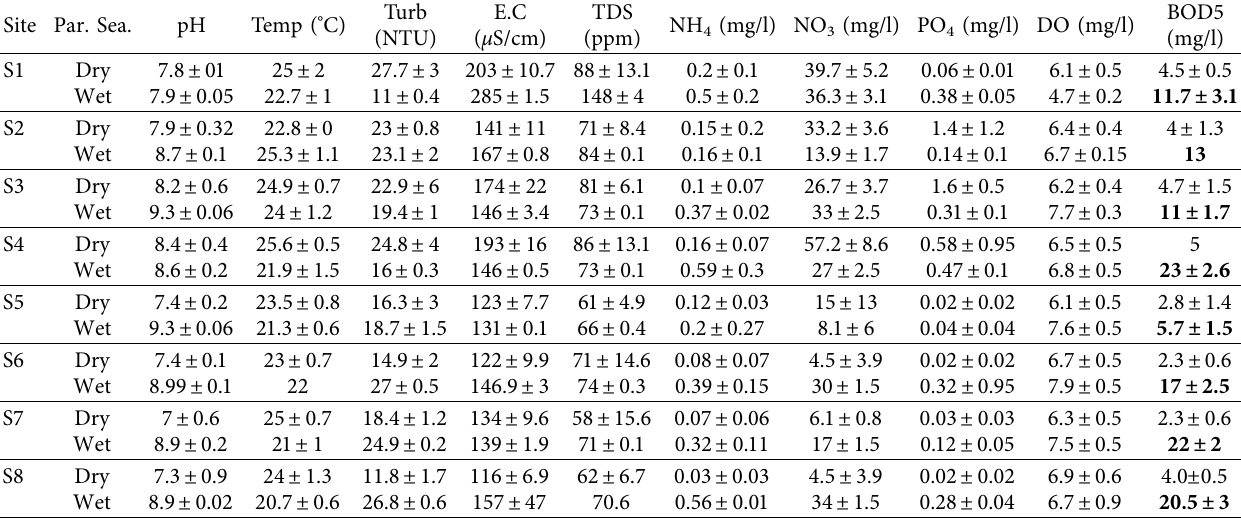
Table 4: Mean and standard deviation of physicochemical parameters measured at the Southern Gulf of Lake Tana ( N � 3), 2021. Site Par. Sea.